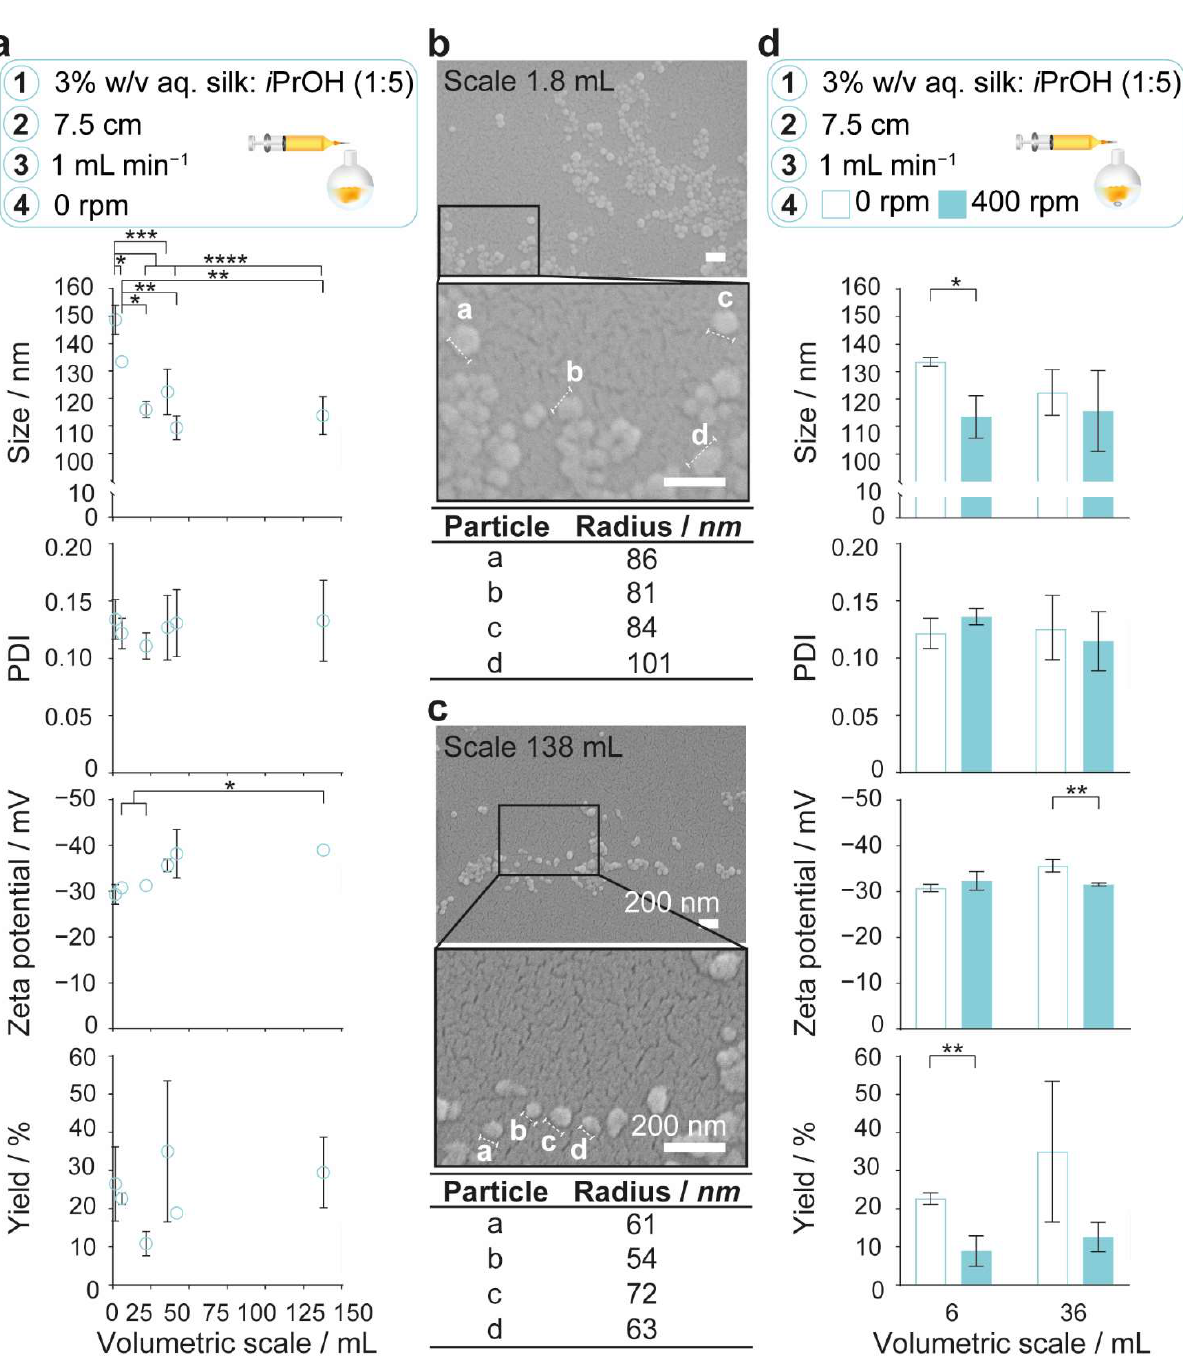
Figure 3. The impact of semi-batch volumetric scale on physicochemical properties and yield of silk nanoparticles. ( a ) Increasing the volumetric scale of silk desolvation in semi-batch format without stirring decreased the nanoparticle size and significantly increased the zeta potential. Multiple groups were evaluated by one-way ANOVA, followed by Tukey’s multiple comparison post hoc test. Scanning electron microscopy of the spherical nanoparticles manufactured at ( b ) 1.8-mL and ( c ) 138-mL scales. ( d ) Impact of the stirring rate and volumetric scale on nanoparticle size and yield. Two groups were evaluated by Student’s t -test. Data obtained from semi-batch manufacture at 6-mL scale and at 36-mL scale at the stirring rate of 400 rpm were from previously published work [30] and were included to simplify the comparison. Error bars are hidden in the plot symbols when not visible, ± SD, n = 3. Asterisks denote statistical significance determined using post hoc tests as follows: * p < 0.05, ** p < 0.01, *** p <0.001, and **** p < 0.0001. Scale bars = 200 nm.